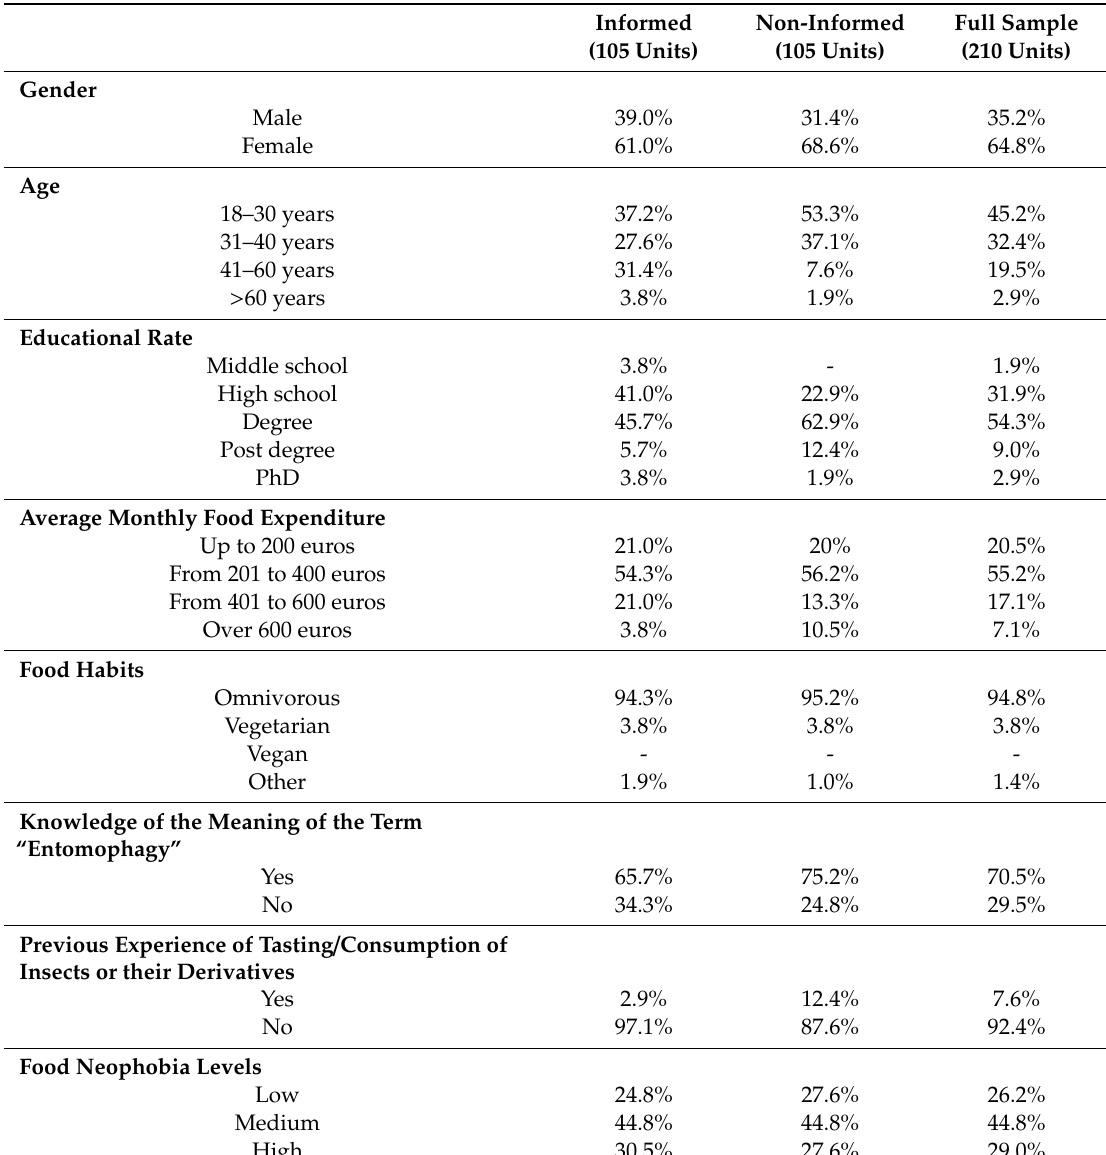
Table 2. Characteristics of the participants and food neophobia